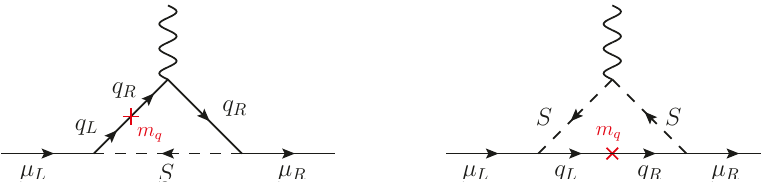
Figure 1 . The chirality-enhanced one-loop contributions to muon dipoles ( presence of scalar S that couples to both left- and right-chiral muons, where S is either R 2 or S 1 and q u; c; t 2 f g